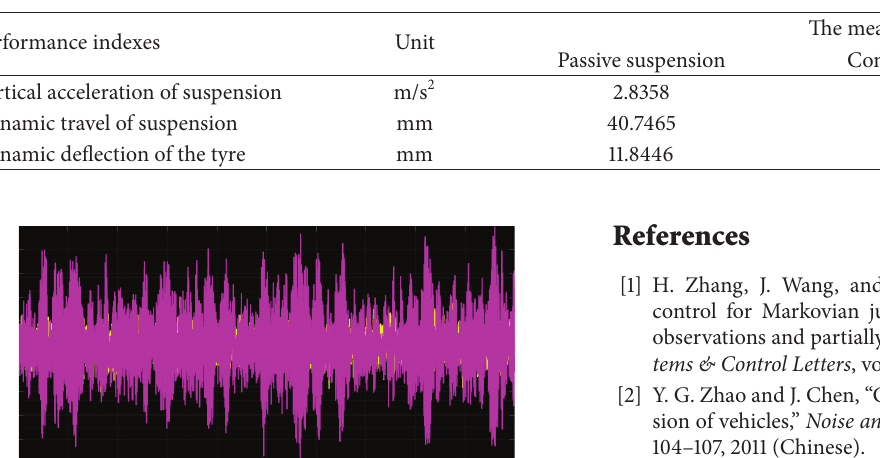
Table 1: Performance contrast of the suspension of different control measures.